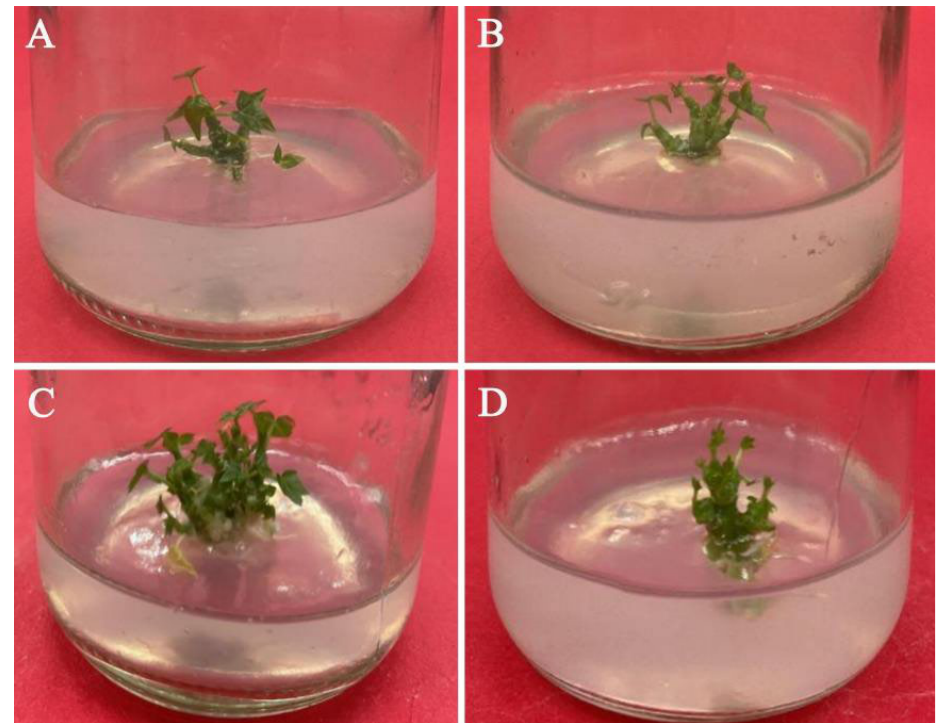
Figure 3. Proliferation and induction of adventitious shoot on medium with different 6-BA concen- trations: ( A ) 1/2 MS medium supplemented with 0.2 mg/L IBA and 1.0 mg/L 6-BA; ( B ) 1/2 MS medium supplemented with 0.2 mg/L IBA and 2.0 mg/L 6-BA; ( C ) 1/2 MS medium supplemented with 0.2 mg/L IBA and 4.0 mg/L 6-BA; and ( D ) 1/2 MS medium supplemented with 0.2 mg/L IBA and 5.0 mg/L 6-BA.